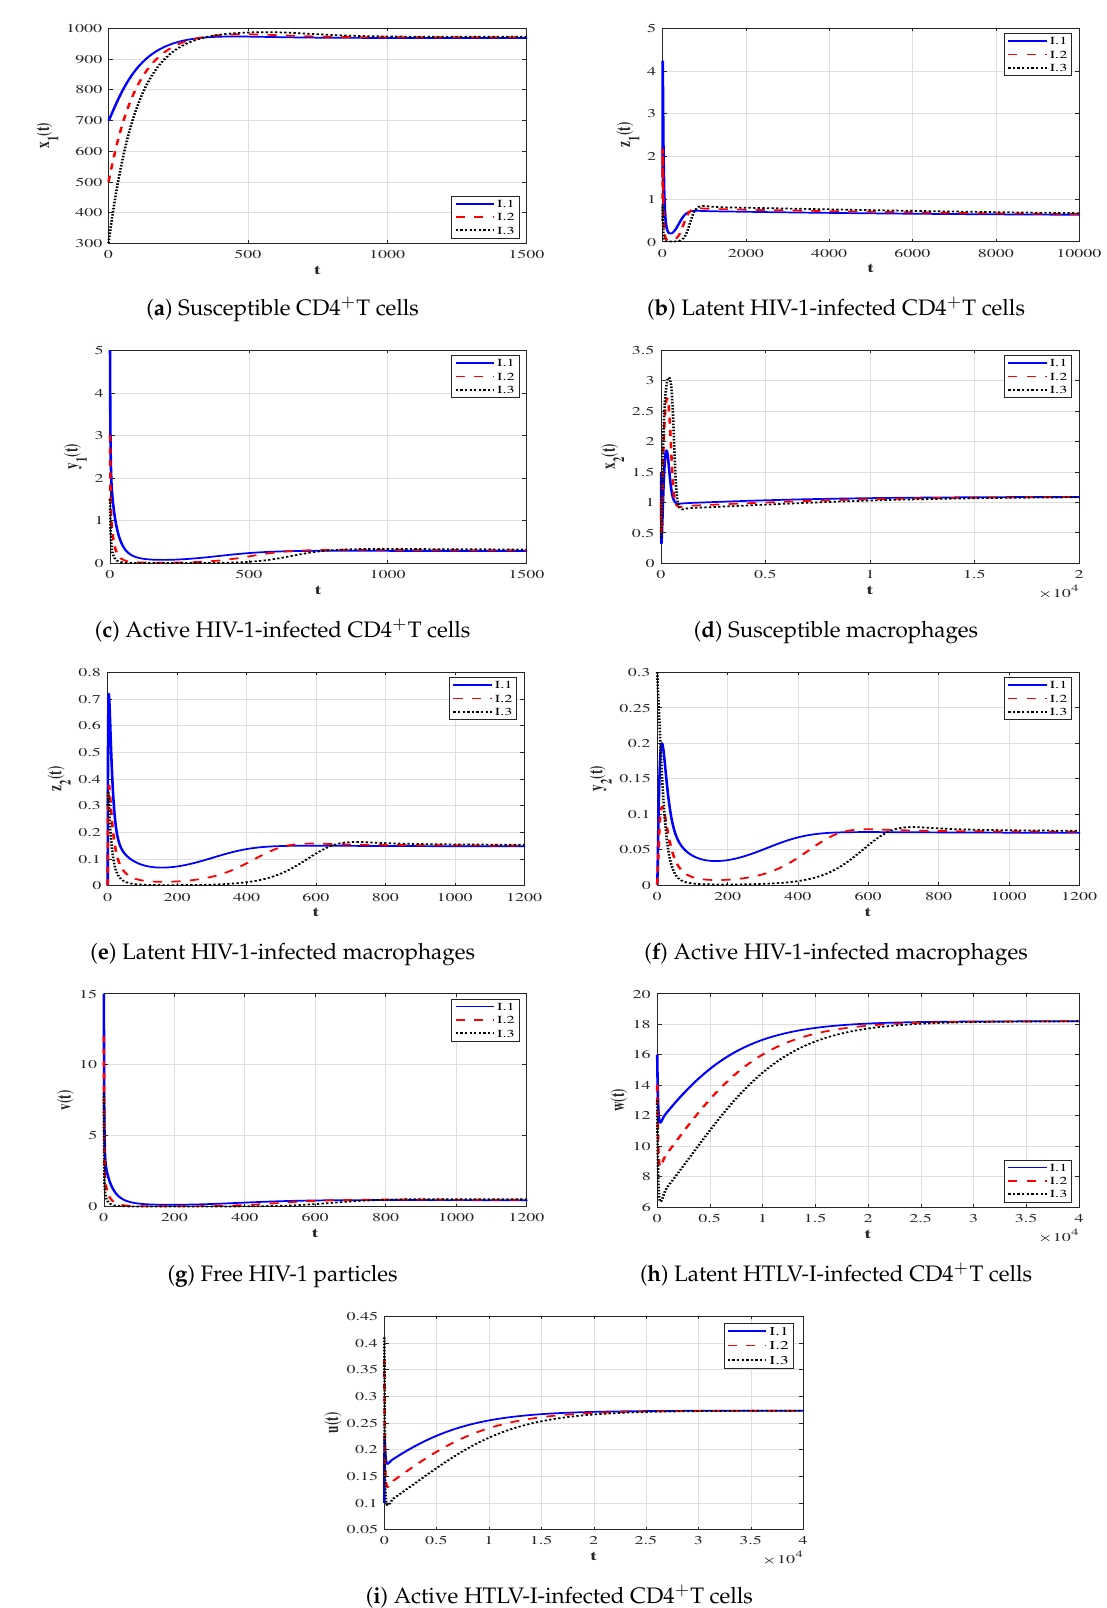
Figure 5. The equilibrium EP 3 = ( 962.96,0.61,0.24,1.09,0.14,0.07,0.39,18.19,0.27 ) is G.A.S when- ever R 2 > 1 , R 3 > 1 and R 4 >